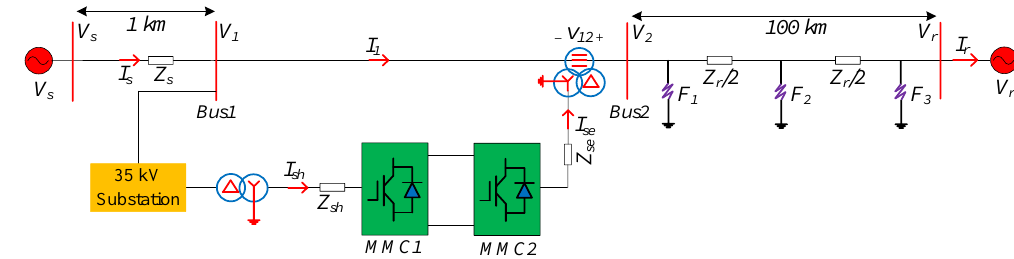
Figure 19. The structural diagram of the tested system in simulation. Table 4. The primary parameters of MMC-based UPFC set in